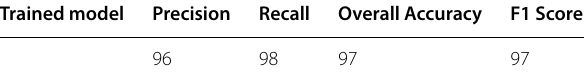
Table 1 Accuracy of the trained model on the test set (%) Trained model